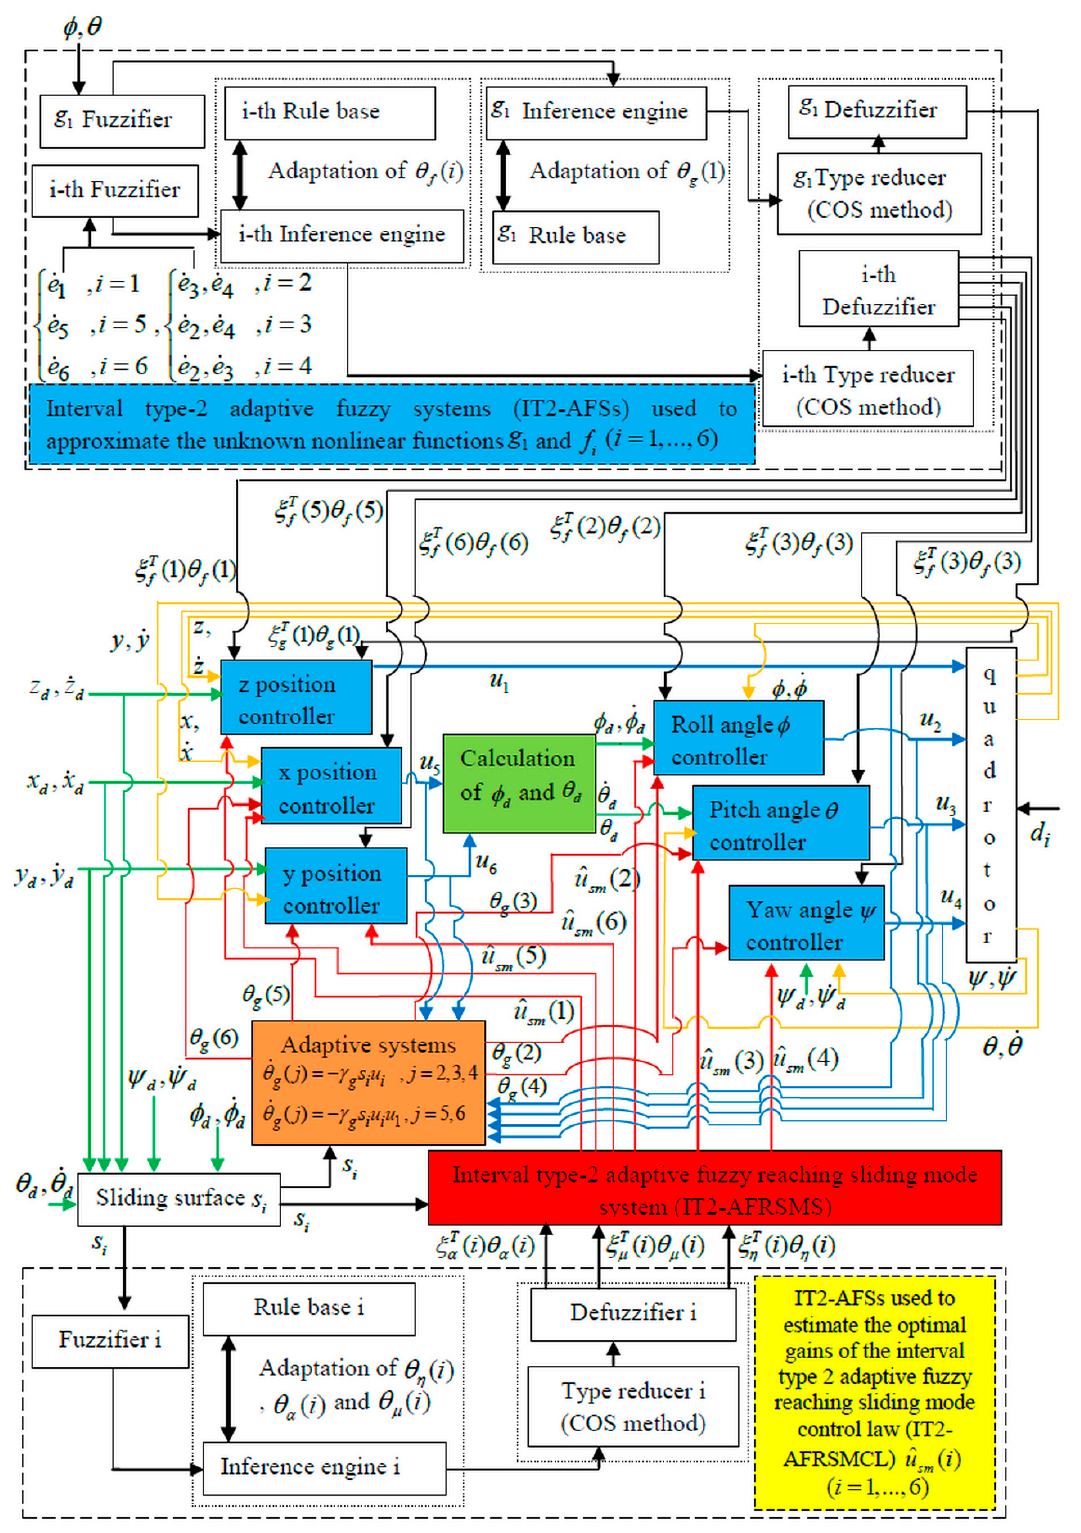
Figure 2. Developed control design scheme.